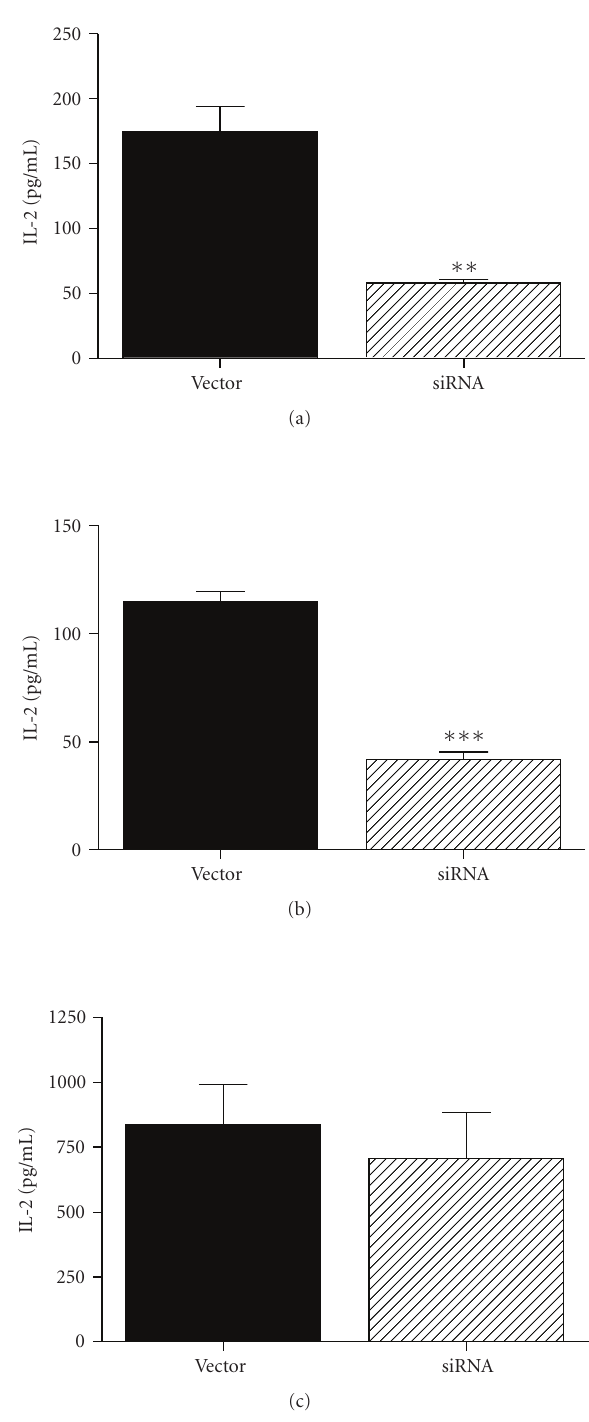
Figure 7: Il-2 production of stimulated Jurkat cells where the expression of TOM1L was reduced by siRNA. The IL-2 production was significantly lower in stimulated cells infected with the hairpin construct (siRNA) as compared with cells infected with a vector lacking the hairpin construct (Vector). (a) Stimulation with plate bound anti-CD3 (1 μ g/well) plus 1 μ g/mL of anti-CD28 antibodies, 48 hours, (b) stimulation with plate bound anti-CD3 (1 μ g/well) plus 0.25 μ g/mL of anti-CD28 antibodies, 48 hours, (c) cells stimulated with 50 ng/mL of PMA plus 0.5 μ g/mL of ionomycin for 48